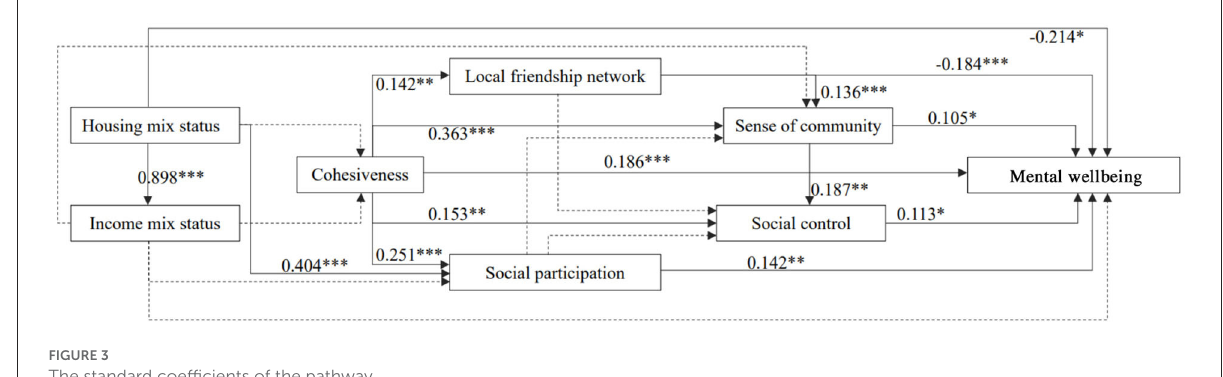
FIGURE3 The standard coefficients of the pathway.